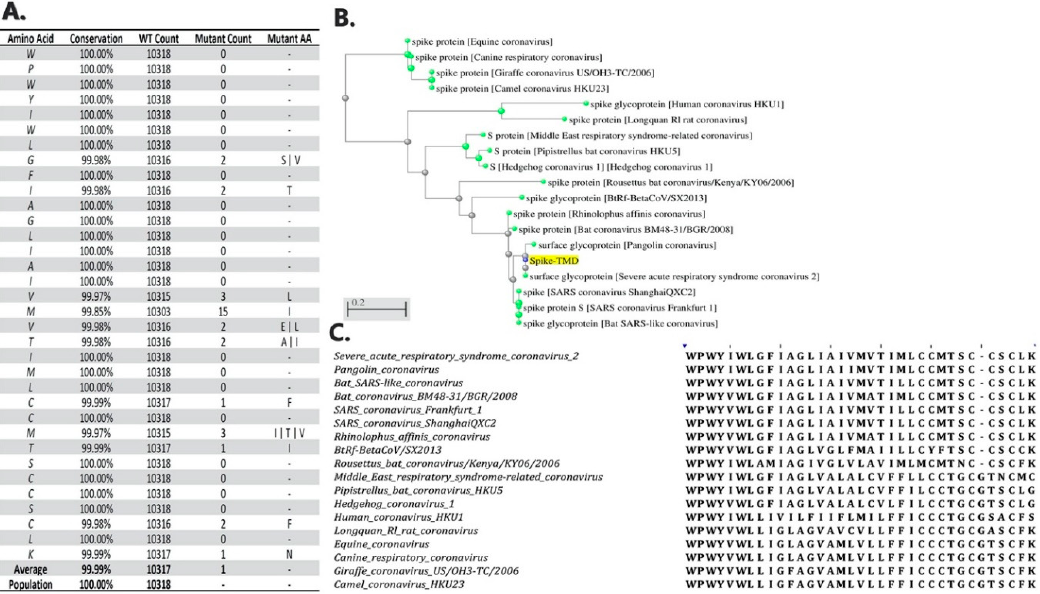
Figure 1. Intra-species conservation and inter-species phylogenetic analyses of the spike transmembrane domain. ( A ) Conservation score of the spike transmembrane domain (TMD) protein sequence between all submitted sequences for surface glycoprotein in severe acute respiratory syndrome coronavirus 2 (SARS-CoV-2) samples. ( B ) Phylogenetic tree of the spike TMD sequence between different members of the Betacoronavirus genus. ( C ) the multiple sequence alignment visualization of the phylogenetic tree sequences.